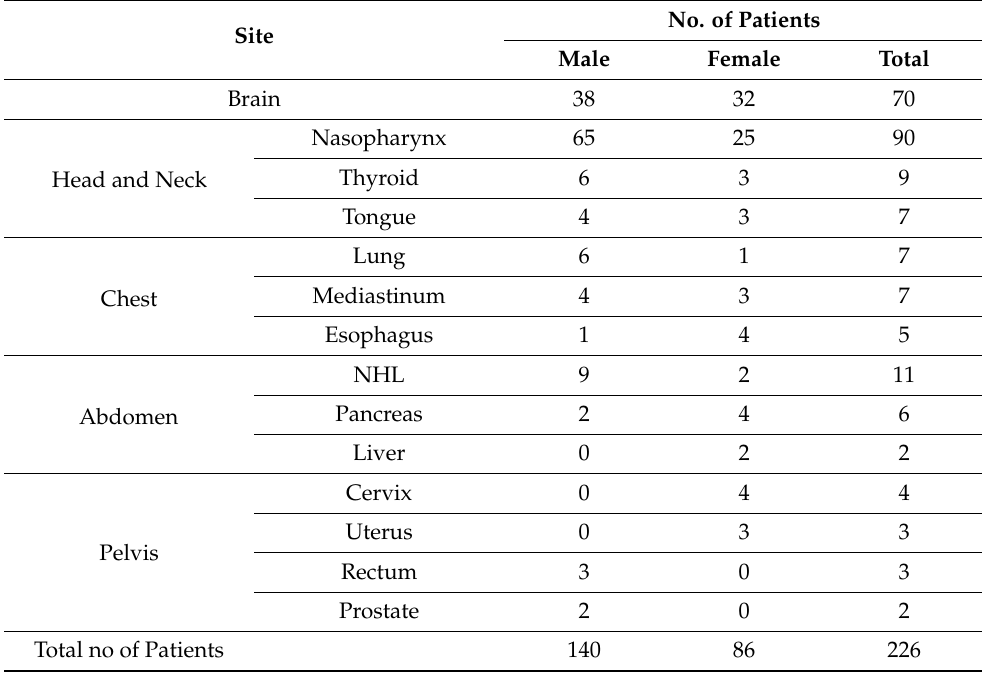
Table 2. Summary of patients’ population and site